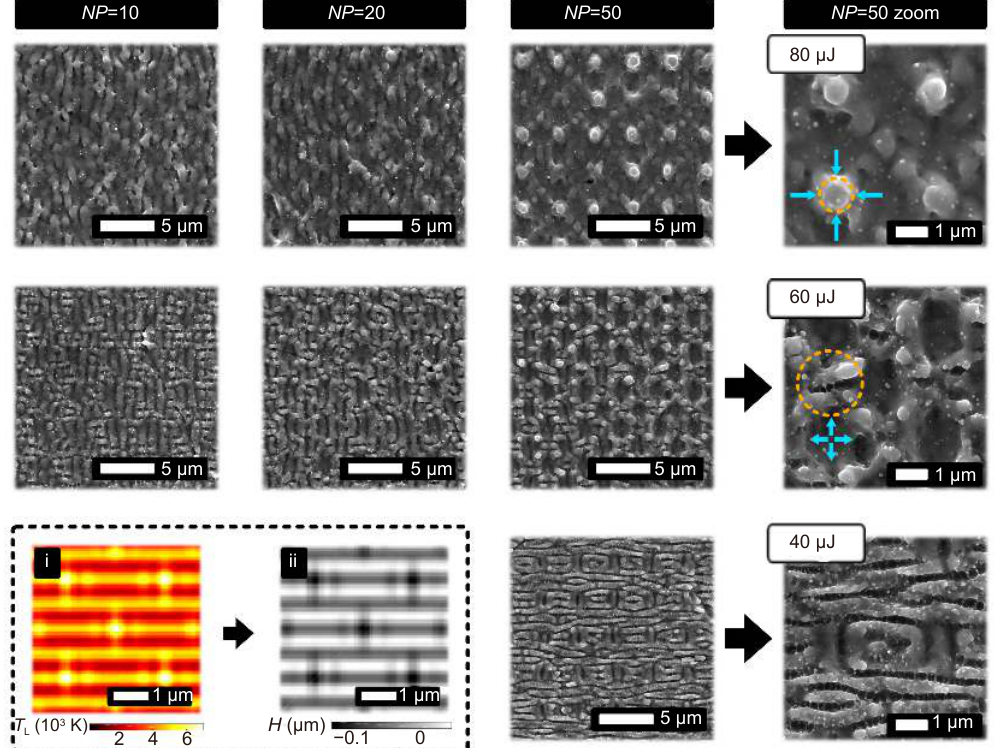
Fig. 5 | Stainless steel surface morphology following variation in pulse energy and NP , as indicated in the respective legends, for the D + G pulse sequence case. The corresponding result of theoretical simulations for 20 μJ pulse energy is shown as an inset defined by the dashed rectangle, illustrating ( i ) the temperature profile for NP = 50 and t = 520 ps and ( ii ) the final surface morphology for NP =